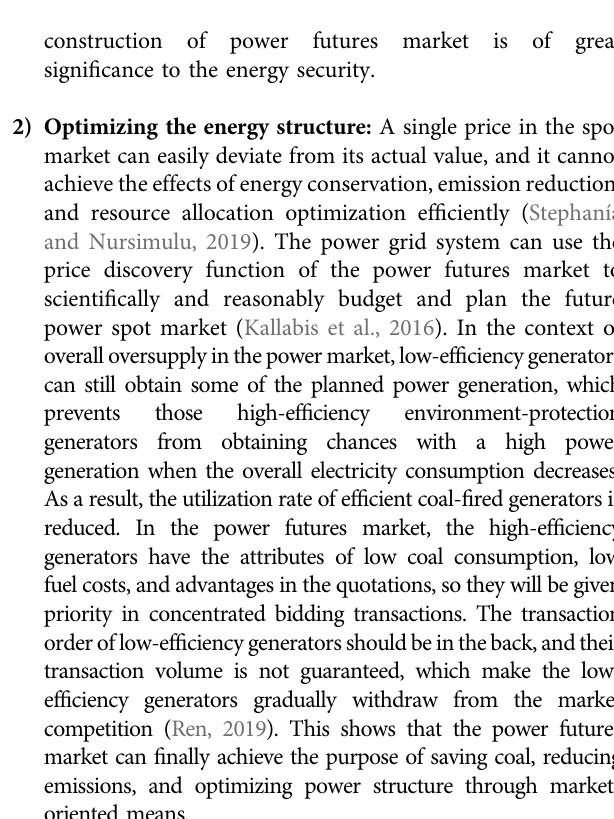
( Figure 6 ). In the carbon emission market, carbon emission